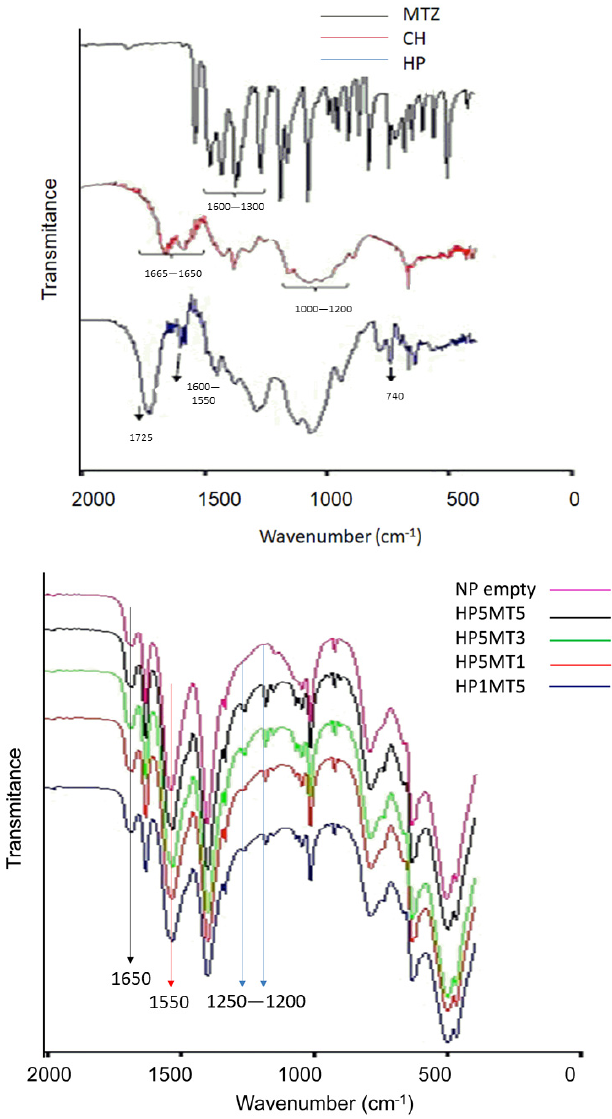
Figure 5. ( A ) Infrared spectra of MT and polymers. ( B ) Infrared spectra of nano PECs of groups HP 1 and HP 5 and empty